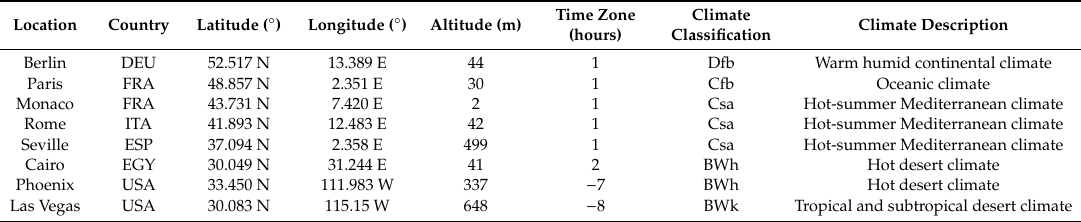
Table 1. Climatic characteristics of the locations.